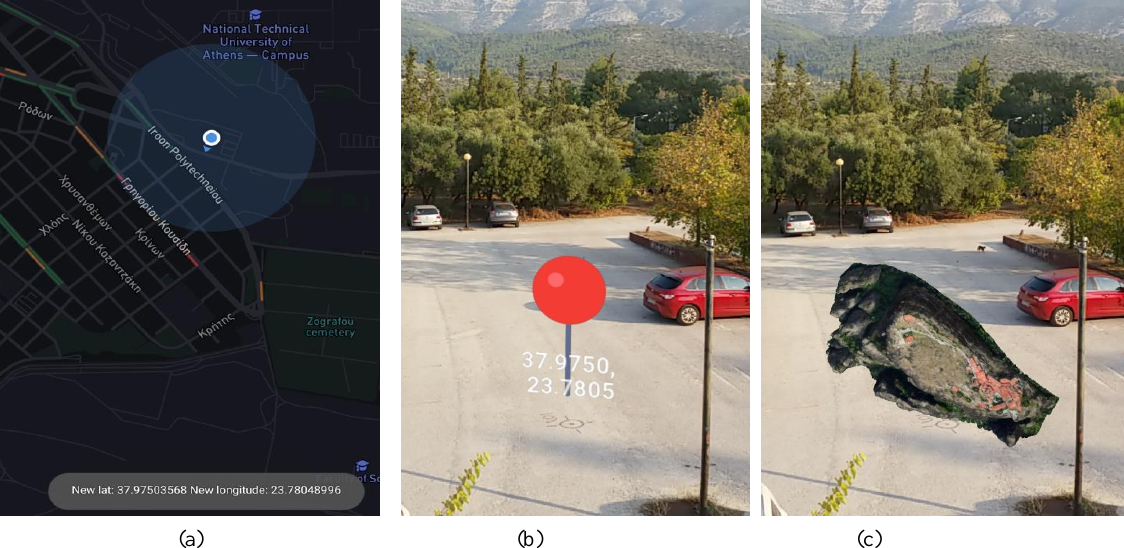
Figure 6. Outdoors location-based approach: (a) The Mapbox‘s map detects and tracks user location by GPS (b) On the reference POI ViroImage and ViroText components are superimposed until model‘s loading (c) 3D overlay at world‘s fixed